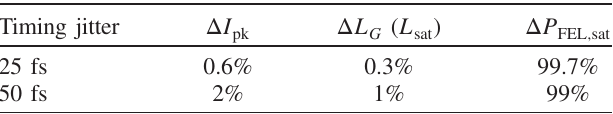
TABLE I. Peak electron beam current and FEL performance variations as a function of correlated timing jitter.